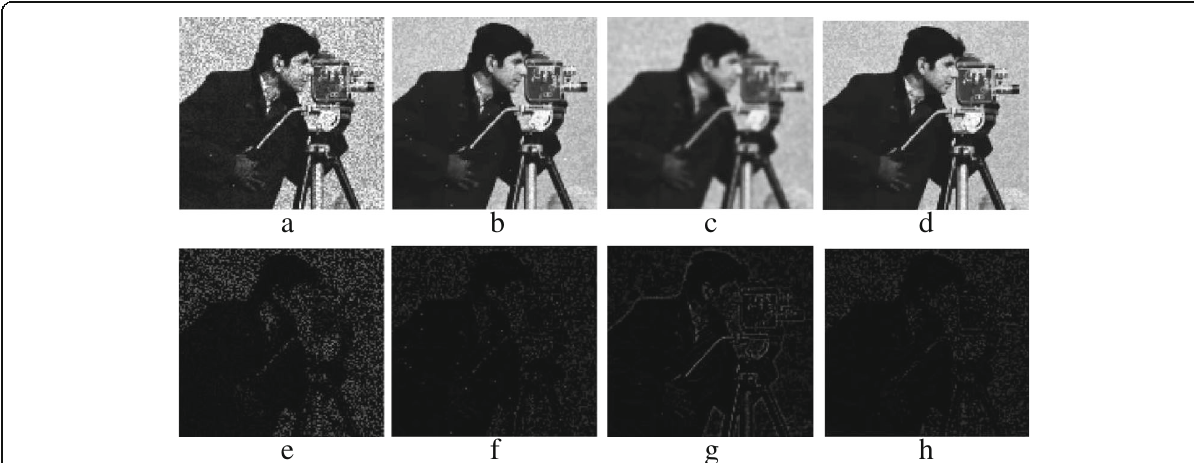
Fig. 4 Zoomed version of the denoised image Cameraman of different methods degraded by a Gamma noise with variance 0.1. a Noisy image,